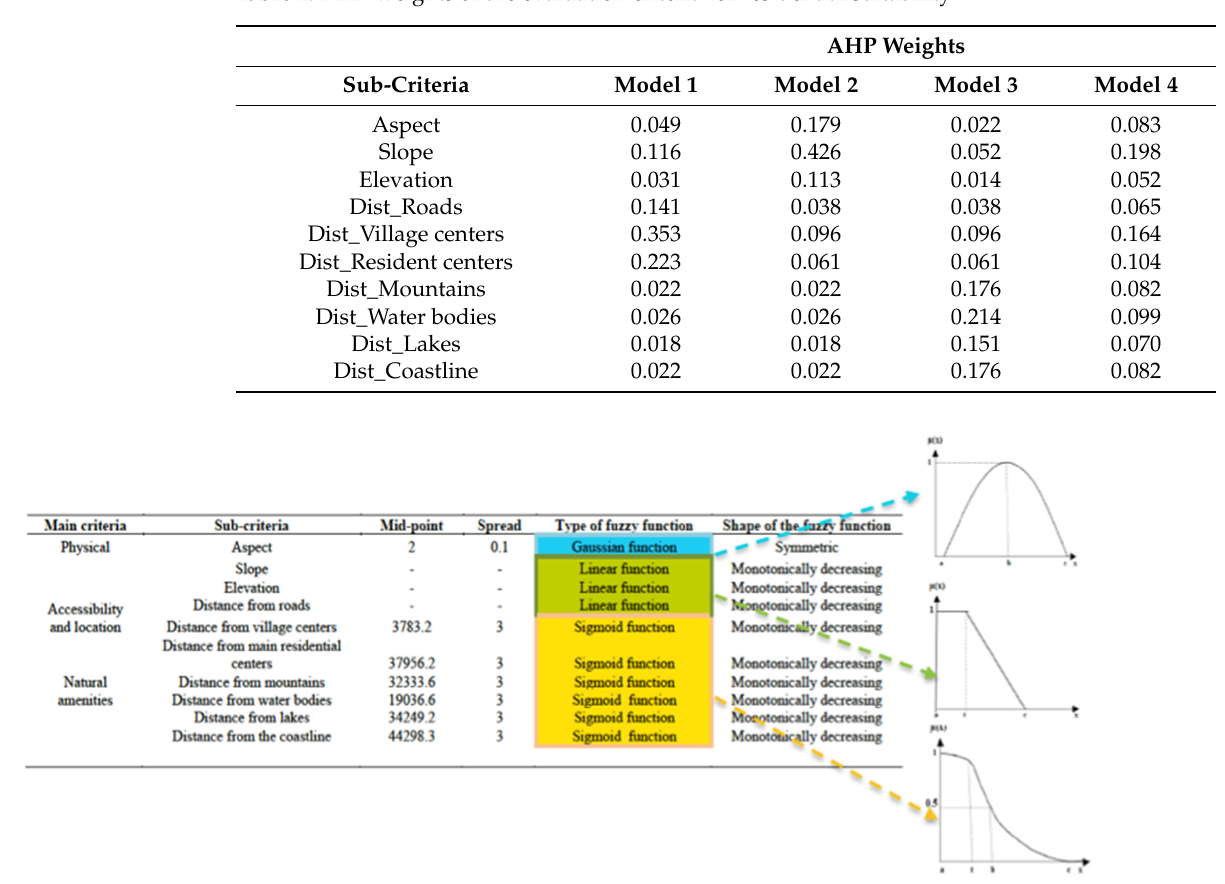
Table 2. AHP weights of the evaluation criteria for residential suitability.